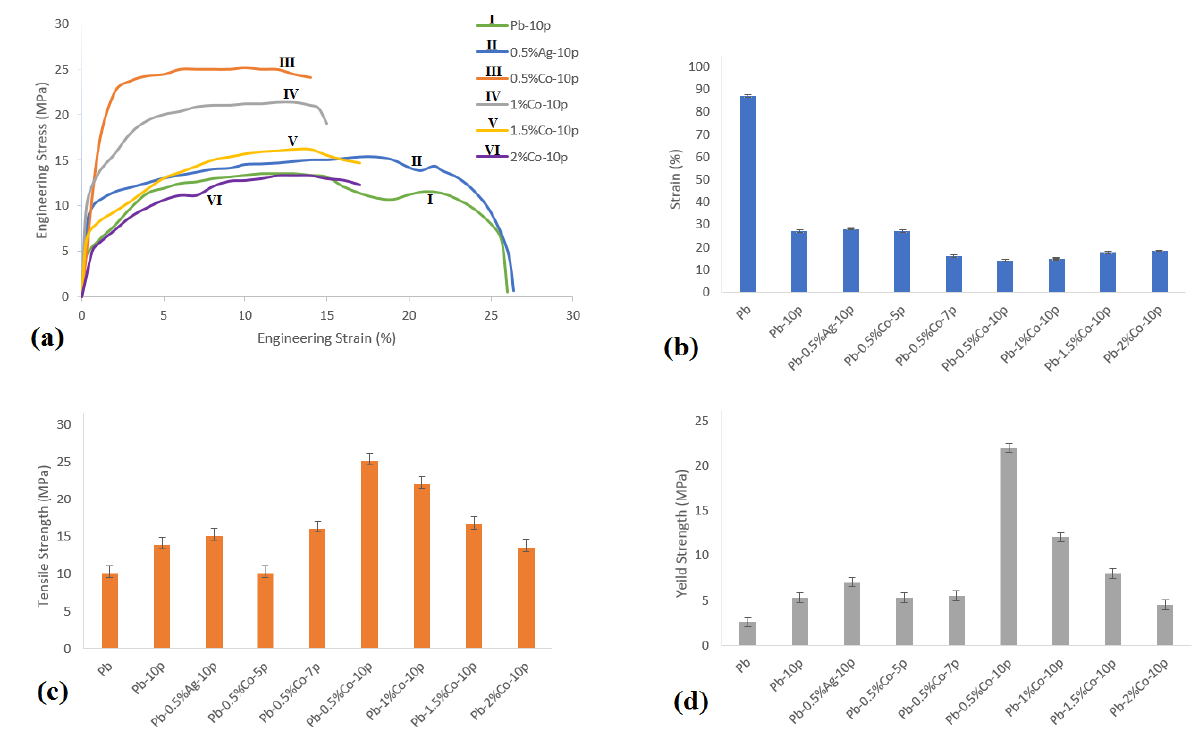
Figure 2. ( a ) Stress – strain curves, ( b ) yield strength, ( c ) tensile strength, and ( d ) strain of various composites.